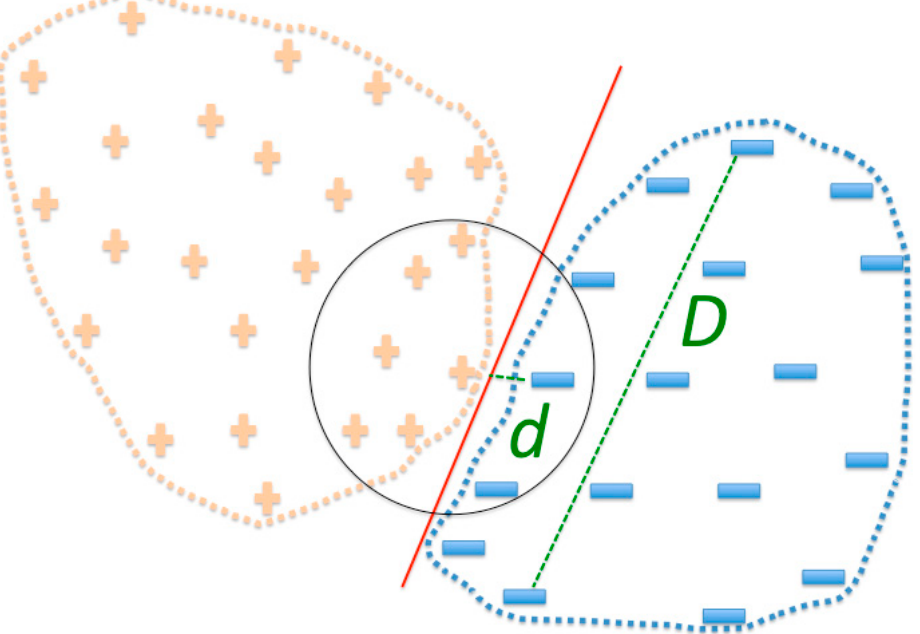
Figure 4. PPI space representation. Based on the distance separation of positive and negative PPI, we envisioned that positive PPI (plus symbols represent instances of positive PPI) would be dispersed over a large region in the space, but close to the negative PPI region(minus symbols represent instances of negative PPI); this proximity is likely the consequence of positive and negative PPI sharing sequence similarity. D represents the diameter of negative PPI, and the distance separating positive and negative PPI sets is represented by d . The red line separating positive and negative PPI sets represents a border that ML methods should be able to identify. The black circle represents k-nearest neighbors.